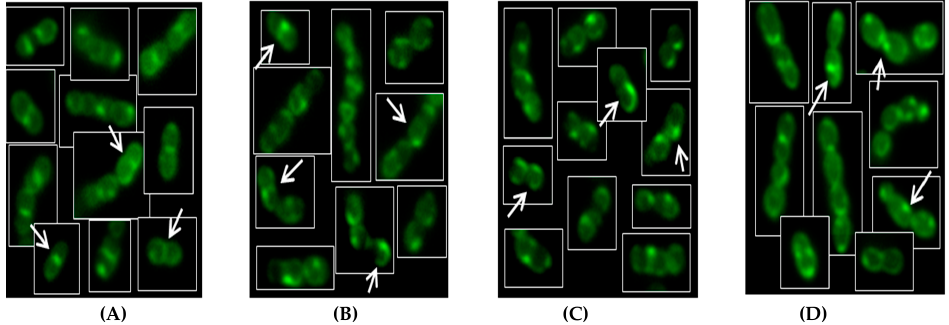
Figure 1. S. mitis-oralis DAP-S SF100 and its DAP-R variants at days 10, 15, 20 post- in vitro DAP passage. Panel A : arrows indicate anionic PL localization at the division septum; Panel B–D : arrows indicate redistribution of anionic PLs away from division septum in DAP-R derivatives (D10, D15, and D20).